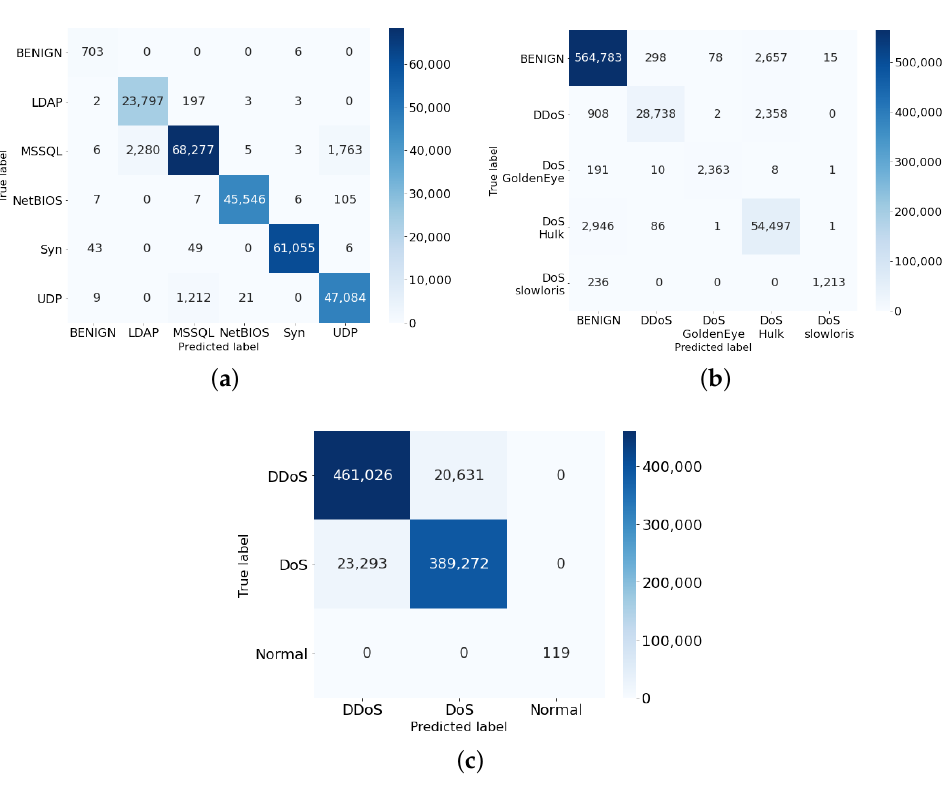
Figure 5. Confusion matrices results on the three test sets. ( a ) CICDDoS2019; ( b ) CIC-IDS2017; ( c )